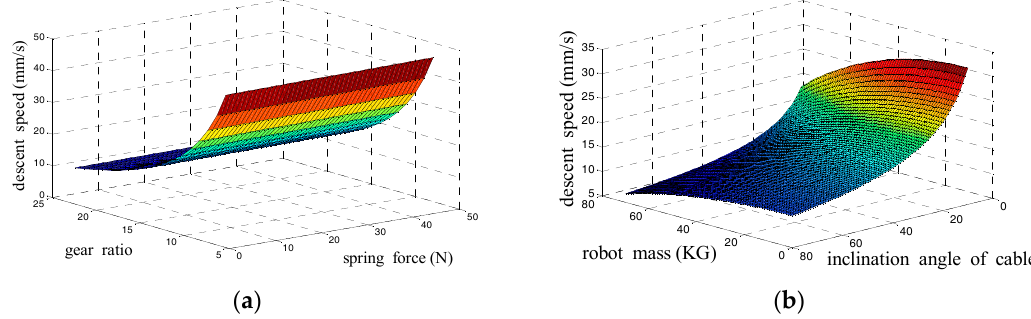
Figure 5. Simulation diagram of descent speed. ( a ) Relationship of descent speed, gear ratio and spring force. ( b ) Relationship of descent speed, robot mass and inclination angle of cables.